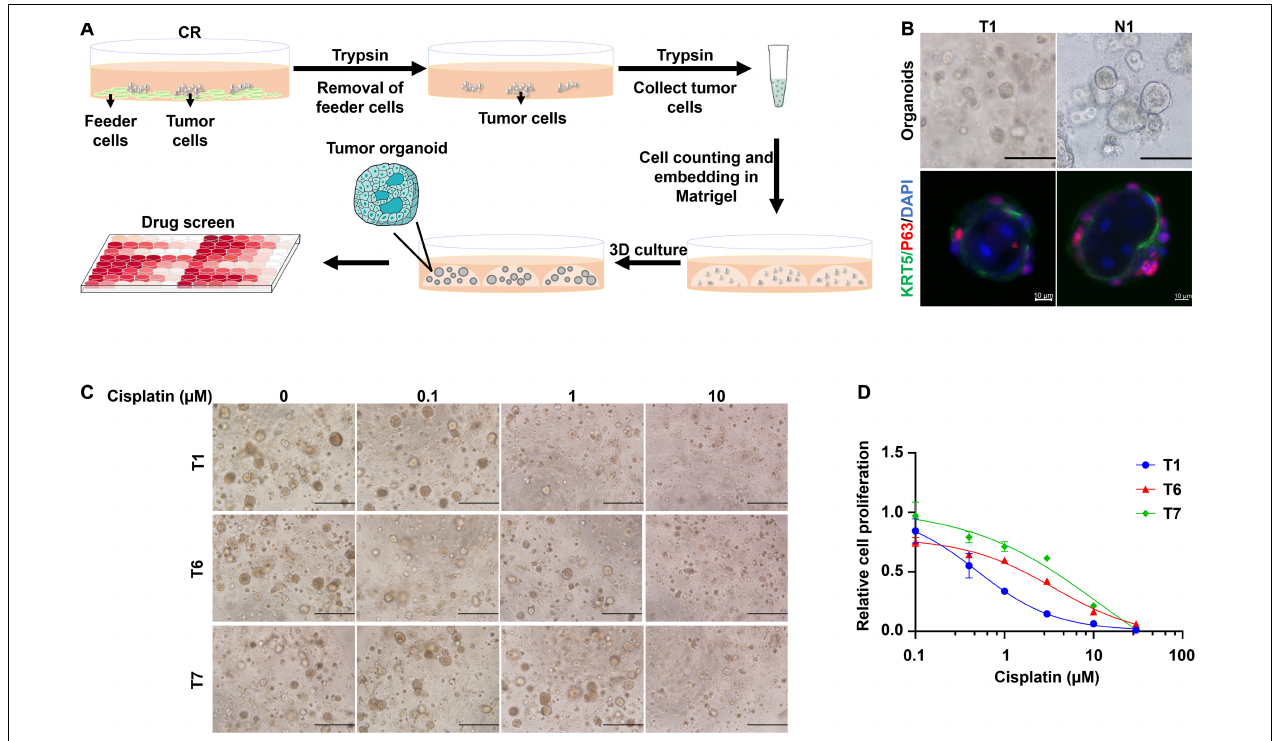
FIGURE 5 | CRCs could form organoids, which could be further used for drug testing. (A) Schematic representation of the culture of CRC-derived organoids and further application for drug testing. (B) Bright-field microscopic images of CRC derived organoids (scale bar, 125 µ m) and immunofluorescence analysis (scale bar, 10 µ m) for the basal cell marker KRT5 (green) and p63 (red). Nuclei were counterstained with DAPI (blue). (C) Bright-field microscopic images of CRC derived organoids treated with different concentrations of cisplatin. Scale bar, 500 µ m. (D) Kill curves of cisplatin to T1, T6, and T7